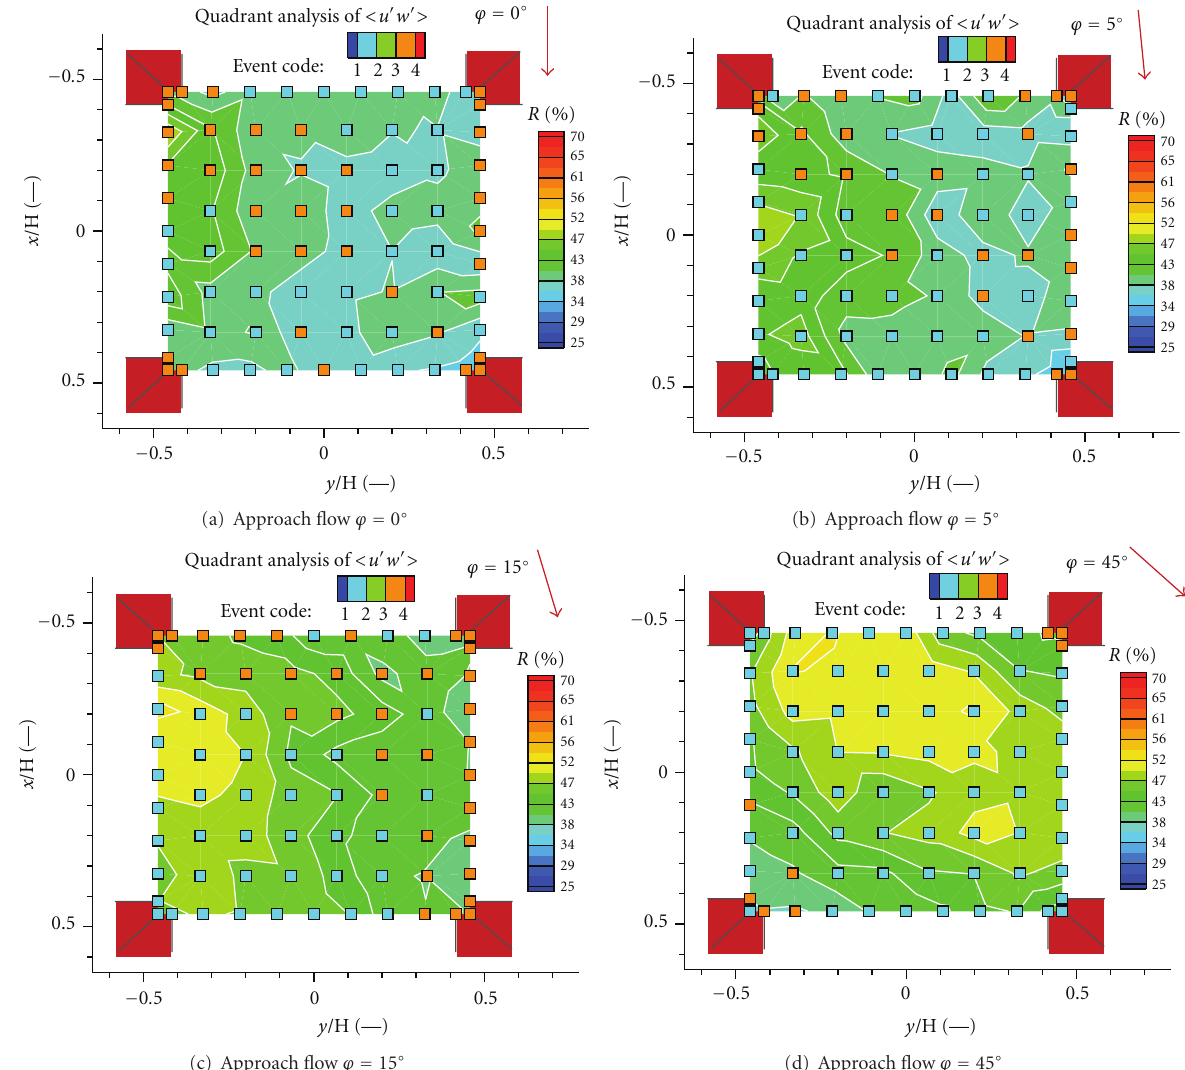
Figure 12: Relative contributions R of dominant event to the total momentum flux (cid:5) u (cid:6) w (cid:6) (cid:7) for four angles of the approach flow direction.